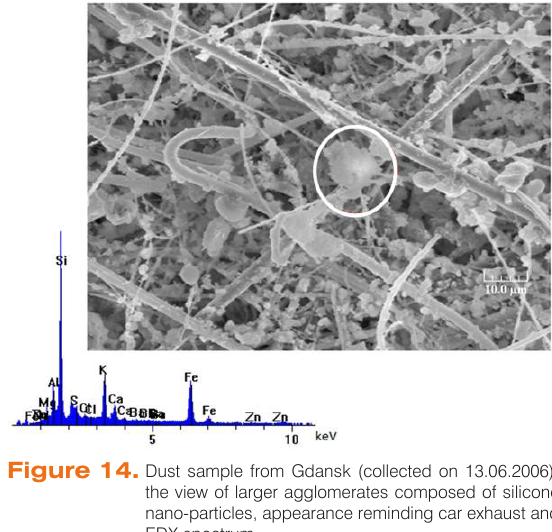
Figure 14. Dust sample from Gdansk (collected on 13.06.2006): the view of larger agglomerates composed of silicone nano-particles, appearance reminding car exhaust and EDX